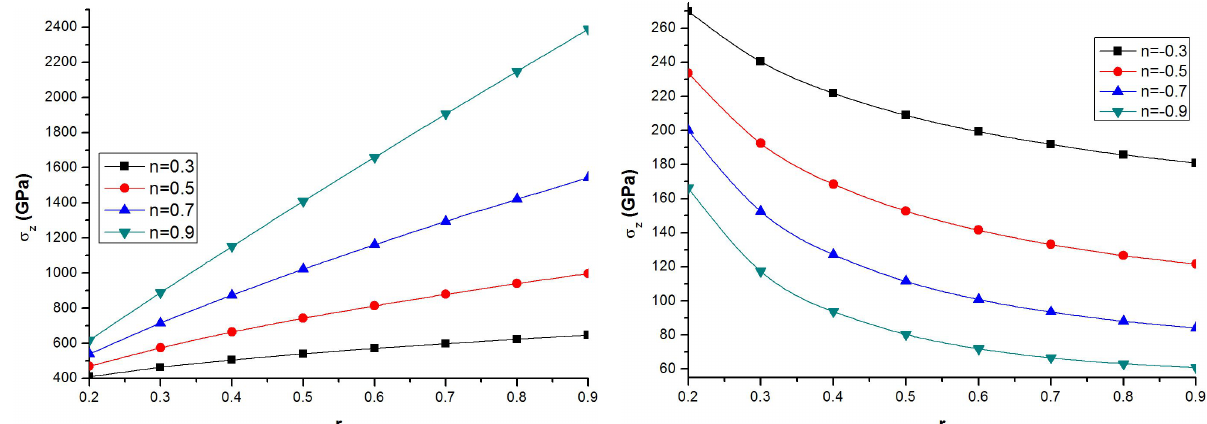
Figure 5: Variation in axial stress against radial coordinate for different values of